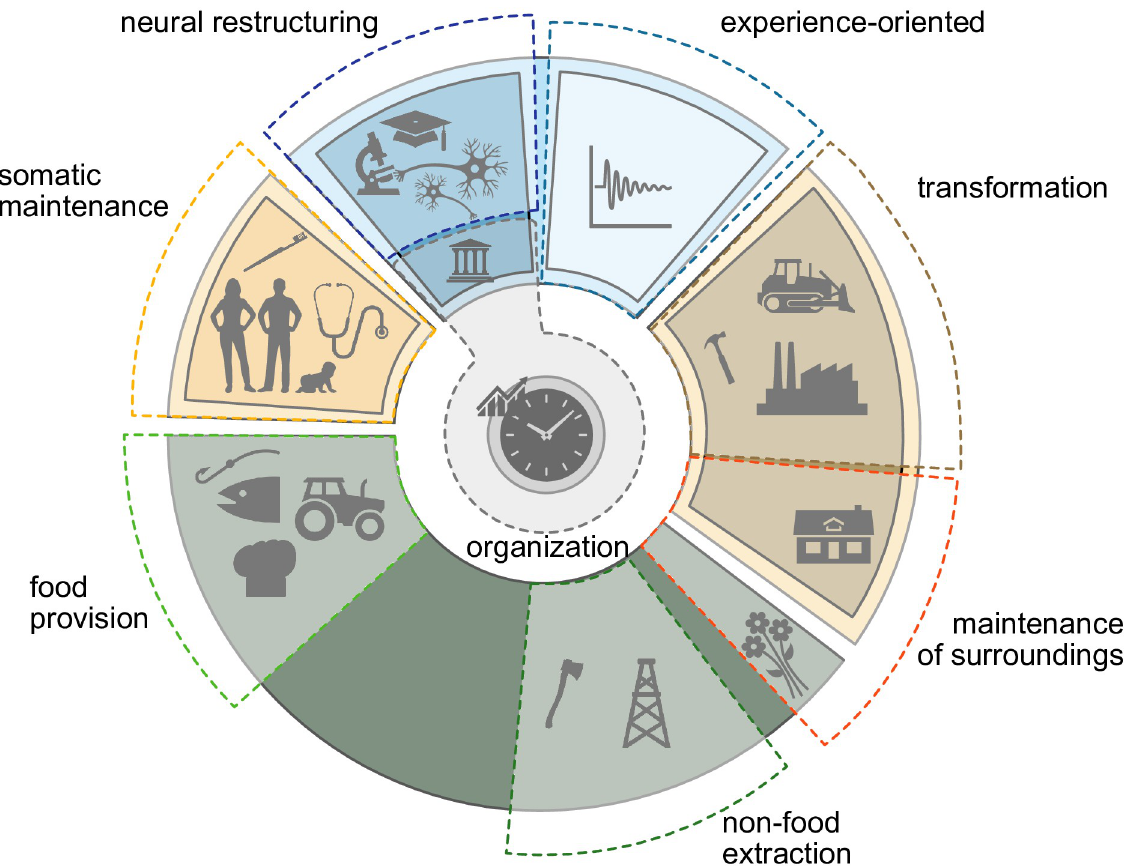
Fig 1. High-level MOOGAL categories. Eight categories of activities are shown schematically in relation to the human-Earth system state variables suggested by [40]. Regions with solid outlines indicate the six state variable classes of the soma (orange), neural structure (dark blue), neural activation (light blue), things (brown), time allocation (grey circle) and remainder of Earth System (green). Dashed outlines indicate relationships of MOOGAL activity categories to state variables. MOOGAL categories can each be associated with one state variable class except maintenance of the inhabited environment , which spans both human-created and natural spaces, and organization , which spans both time allocation and neural structures (via laws and other cultural norms). Note that organization also includes changing the locations of humans, food, materials and